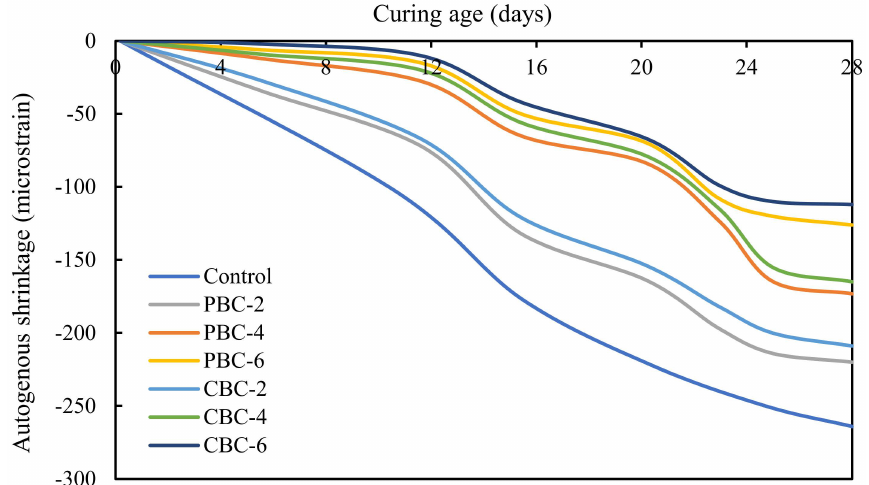
Figure 9. Results of the autogenous shrinkage of the concrete mixtures at different